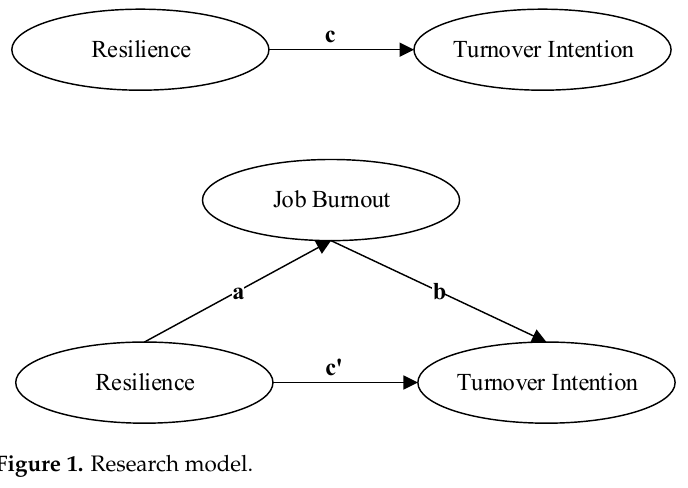
Figure 1. Research model.